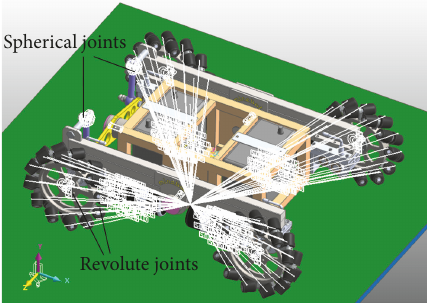
Figure 2: Simulation model of the